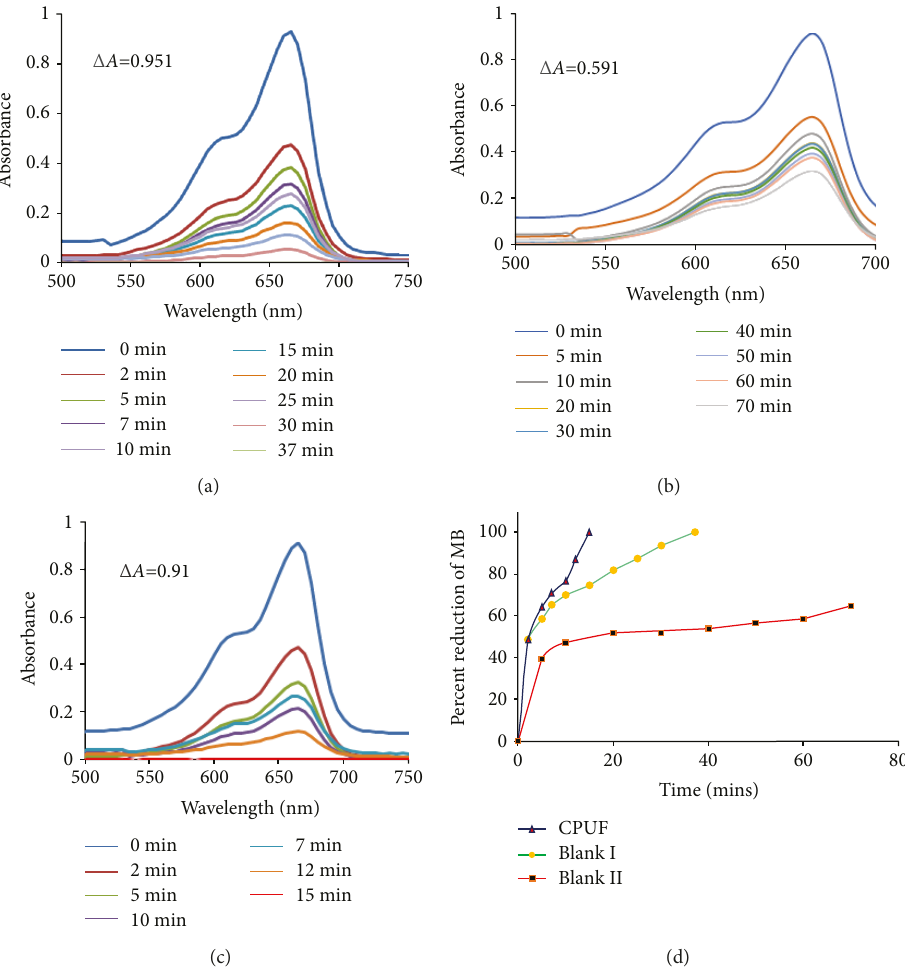
Figure 3: UV-Vis absorption spectra recorded for the progress in reduction of MB dye: (a) 2.5mL of MB ( 2 5 × 10 − 5 M ) solution and 2.5mL of ascorbic acid ( 1 5 × 10 − 5 M ) solution named as blank I, (b) 2.5mL of MB ( 2 5 × 10 − 5 M ) solution with 0.25g of CPUF named as blank II, (c) 2.5mL of MB ( 2 5 × 10 − 5 M ) solution and 2.5mL of ascorbic acid ( 1 5 × 10 − 5 M ) solution with 0.25g of CPUF, and (d) comparison of percent reduction of MB as a function of time in (a), (b), and